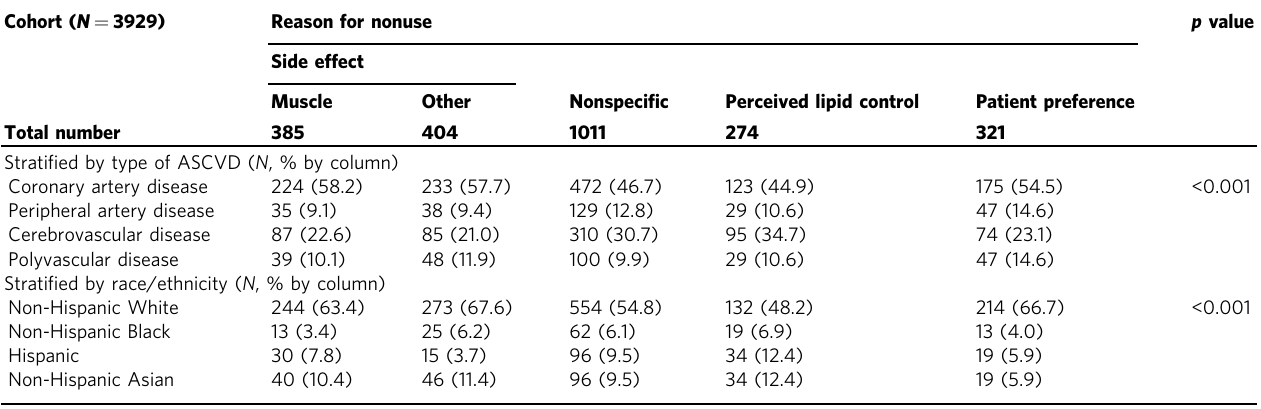
Table 3 NLP-identi fi ed reasons for statin nonuse in patients with ASCVD, strati fi ed by type of ASCVD and race/ethnicity. Cohort ( N = 3929)